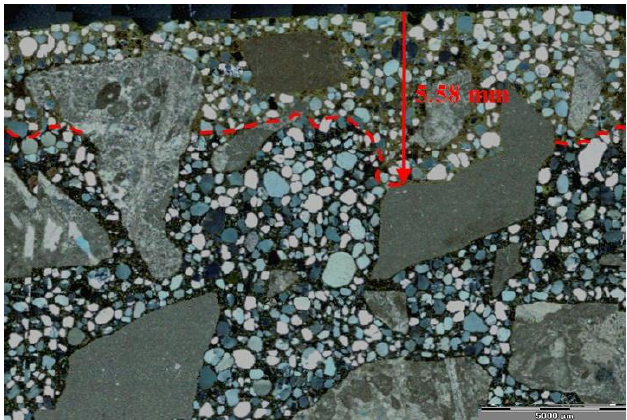
Figure 6. Thin-section view of concrete with limestone aggregate and CEM I with visible carbonation front, after 56 days of exposition in 1% CO 2 , XPL, scale bar = 5000 µm.